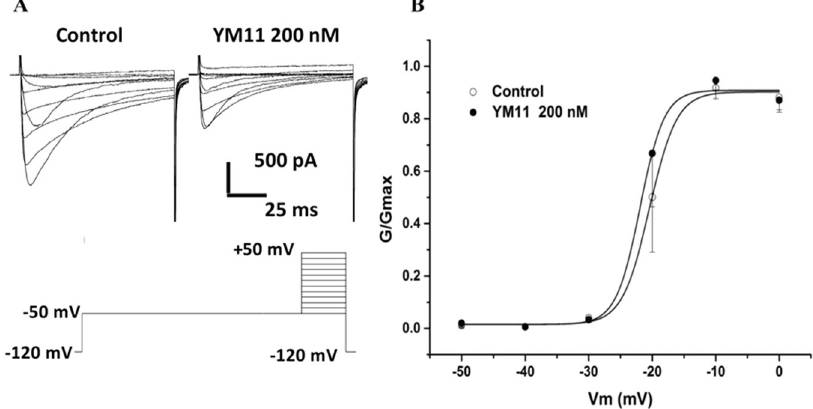
Figure 14. Changes of Na v 1.8 steady-state activation curves among control. The values of the parameters of V 1 / 2 and K were − 20.42 ± 0.36 mV and 2.31 ± 1.26 (n = 5) under control condition, − 21.90 ± 1.51 mV and 1.90 ± 1.43 (n = 5) in rat L4–6 DRG